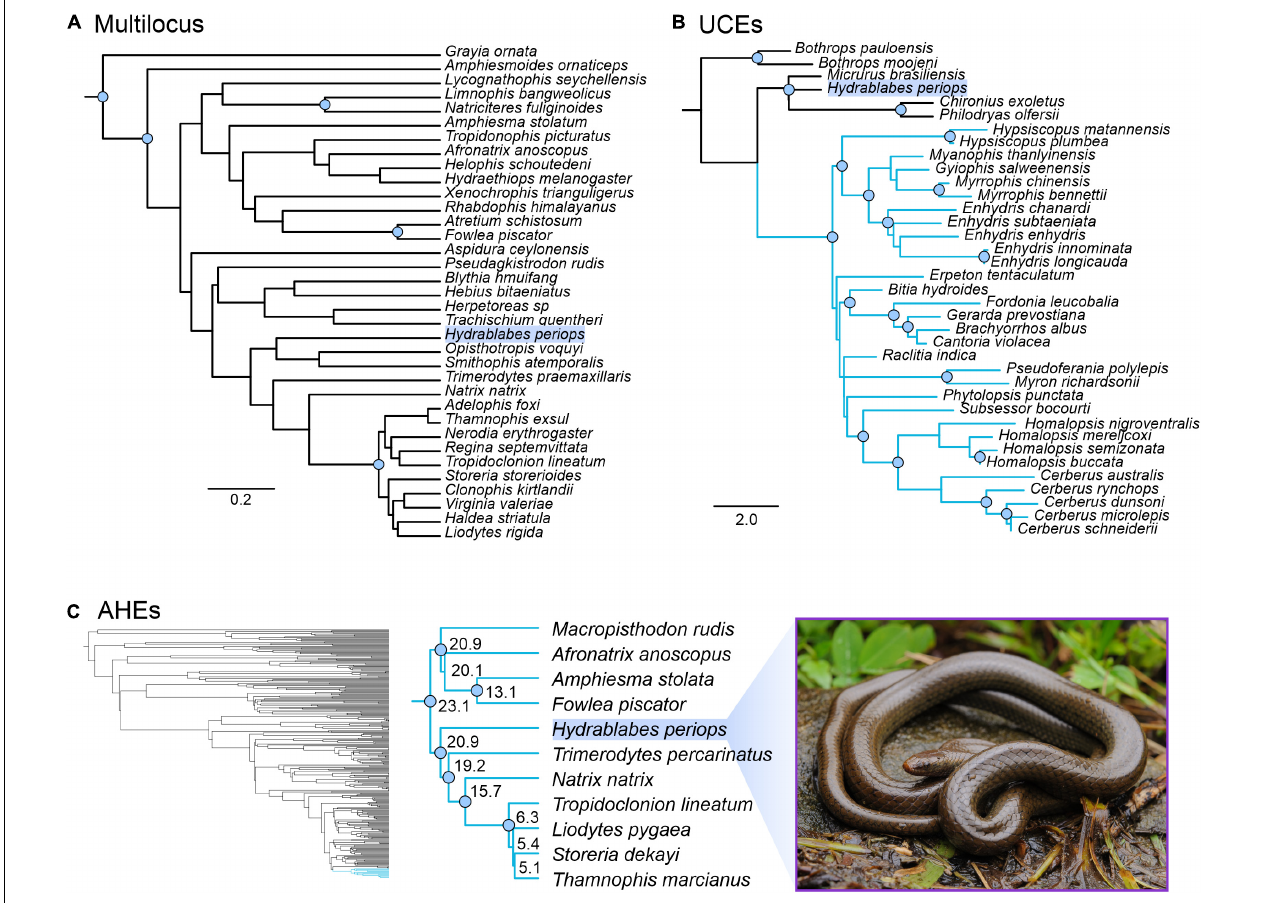
FIGURE 4 | Phylogenetic placement of Hydrablabes periops using three datasets from other studies. (A) Species tree using one nuclear and two mitochondrial genes (outgroup = Grayia ); scale bar in nucleotide substitutions per site. (B) Homalopsidae species tree using UCEs; blue clade = Homalopsidae, scale bar in coalescent units. (C) Squamate species tree using AHEs; blue clade = Natricidae, numbers on enlarged Natricidae clade represent divergence dates in millions of years. Node circles in all trees indicate strongly supported relationships (Bpp ≥ 0.95; not shown for Squamata AHE tree). Photo credit of live H. periops : Chien C.